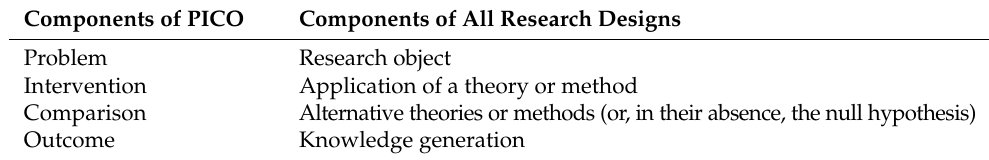
Table 2. The universal PICO